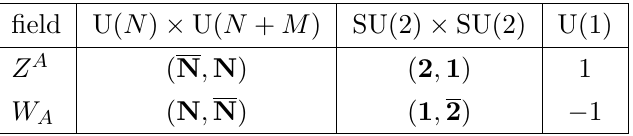
Table 1 . Matter content of ABJM theory and their transformations under gauge and flavor sym- metries in N = 2